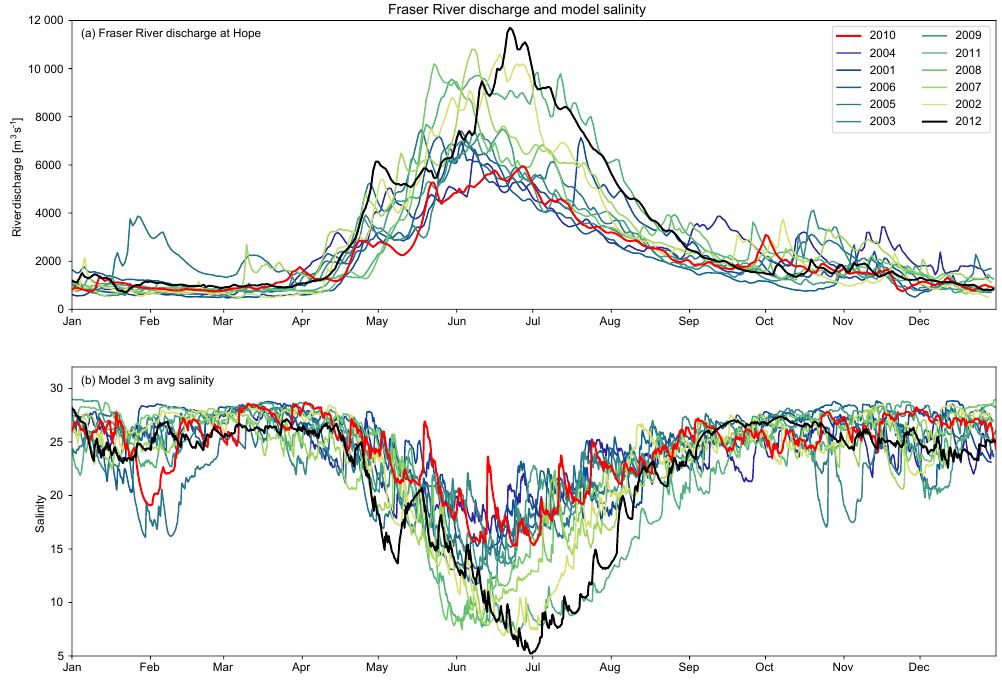
Figure 3. (a) Fraser River discharge at Hope versus year day and (b) model top 3m averaged salinity shown for each year in the 12-year period considered in this study. The Fraser River flow regime is characterized by a prominent summer freshet associated with summer glacial melt and smaller rainfall-dominated winter spikes. Model salinity reflects this overall pattern. Individual years are plotted in order of increasing freshet (peak) size. The smallest (2010) and largest (2012) flow years are highlighted in red and black, respectively.